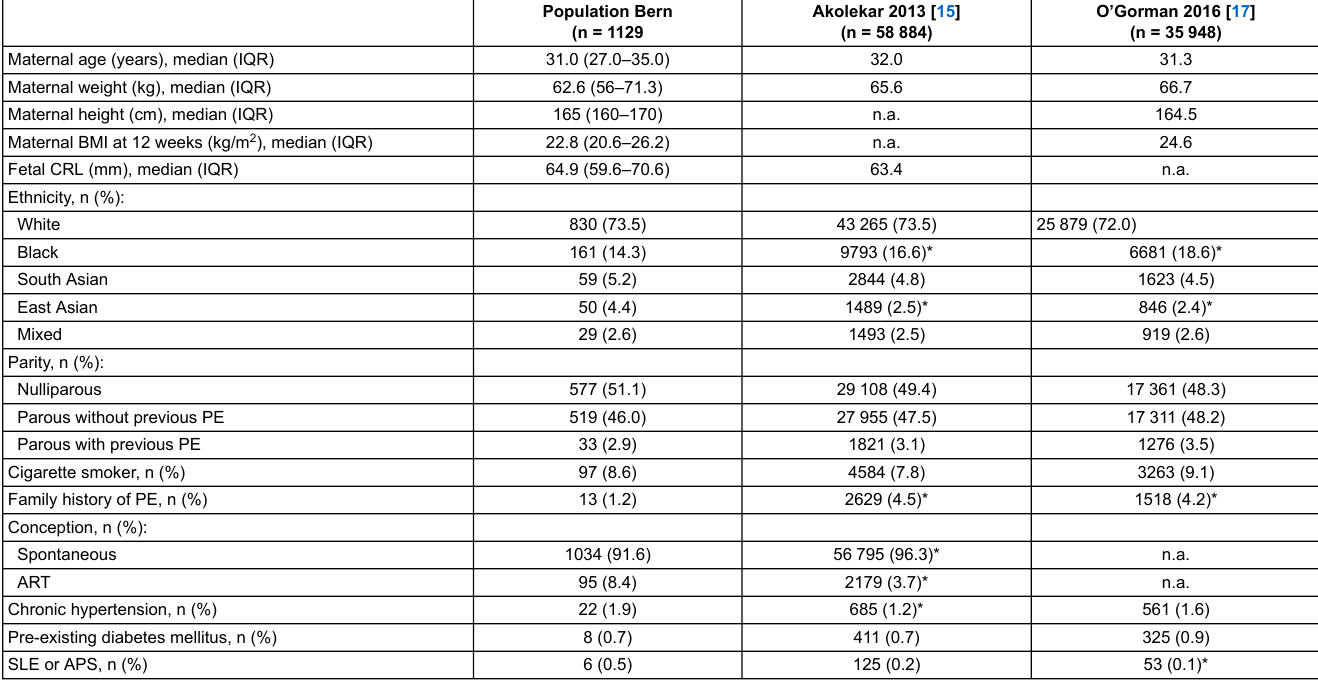
Table 2: Comparison of our collective with the collectives used by the FMF London in the development [15] and validation [17] of the preeclampsia screening algorithm.